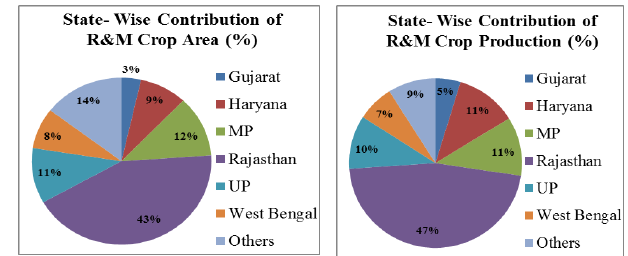
Figure 2. State-wise average (2012 to 2017) contribution to Rapeseed & Mustard area and production (Source: DES, DAC&FW)